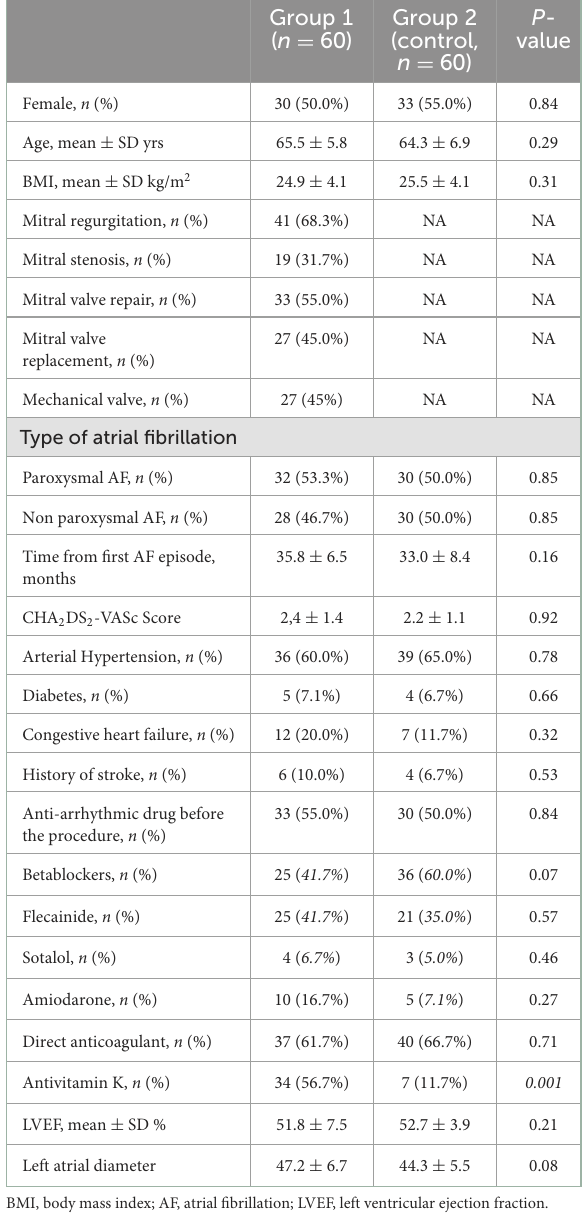
TABLE 1 Clinical and index procedure characteristics ( n =